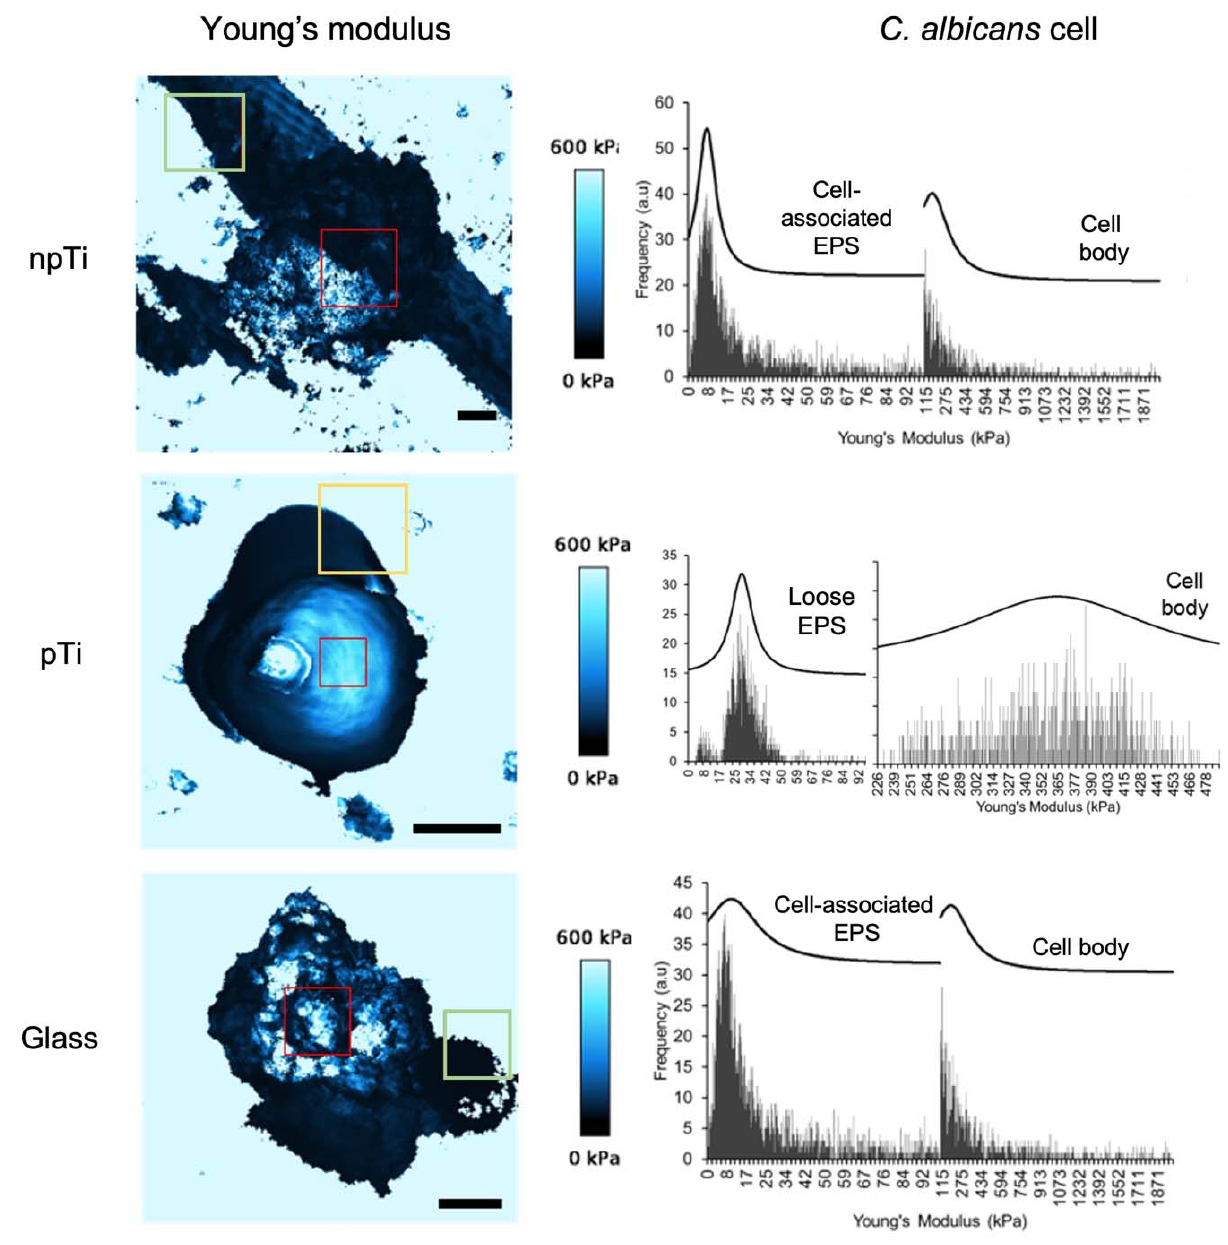
Figure 3. The mechanical properties of C. albicans cells. Representative Young’s modulus values of C. albicans cells attached on npTi, pTi, and glass surfaces after a 3-day incubation period. The elasticity of C. albicans, including cell body and excreted EPS, was obtained by using Hertz/Seddon model for soft materials on 65,536 AFM force curves. The dark and bright blue color in the elasticity maps represent soft and hard matter, respectively. Young’s modulus data highlighted by the red squares were extracted and constructed into histograms. These histograms were fitted with Gaussian function to extract a nominal Young’s modulus value (elasticity value) for specific materials, i.e., for the cell body and cell-associated EPS. Cell-associated EPS was not detected on C. albicans cells attached on pTi. The red, yellow, and green boxes indicate the cell body, the loose EPS, and the cell-associated EPS, respectively. Scale bars are 2 µm.